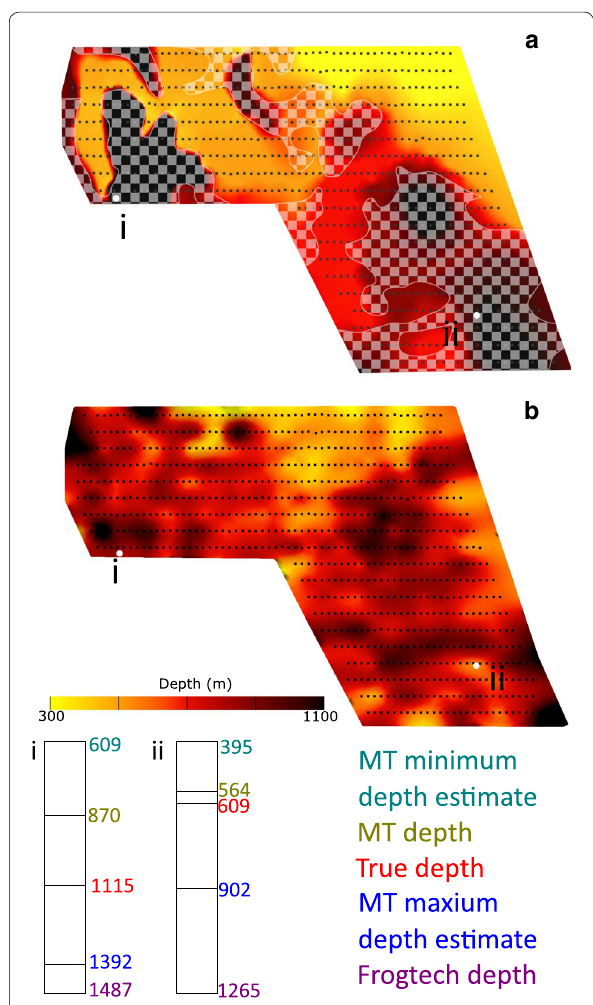
Fig. 13 Comparison of new and existing basement interpretations to known drilling intercepts. a The Frogtech Geoscience (2018) interpretation overestimates the true basement depths. Hatched areas indicate areas of the Frogtech interpretation that are deeper than the MT maximum depth estimate surface b New interpretation of basement underestimate the true depth of basement, but when used in association with error estimates is consistent with the known